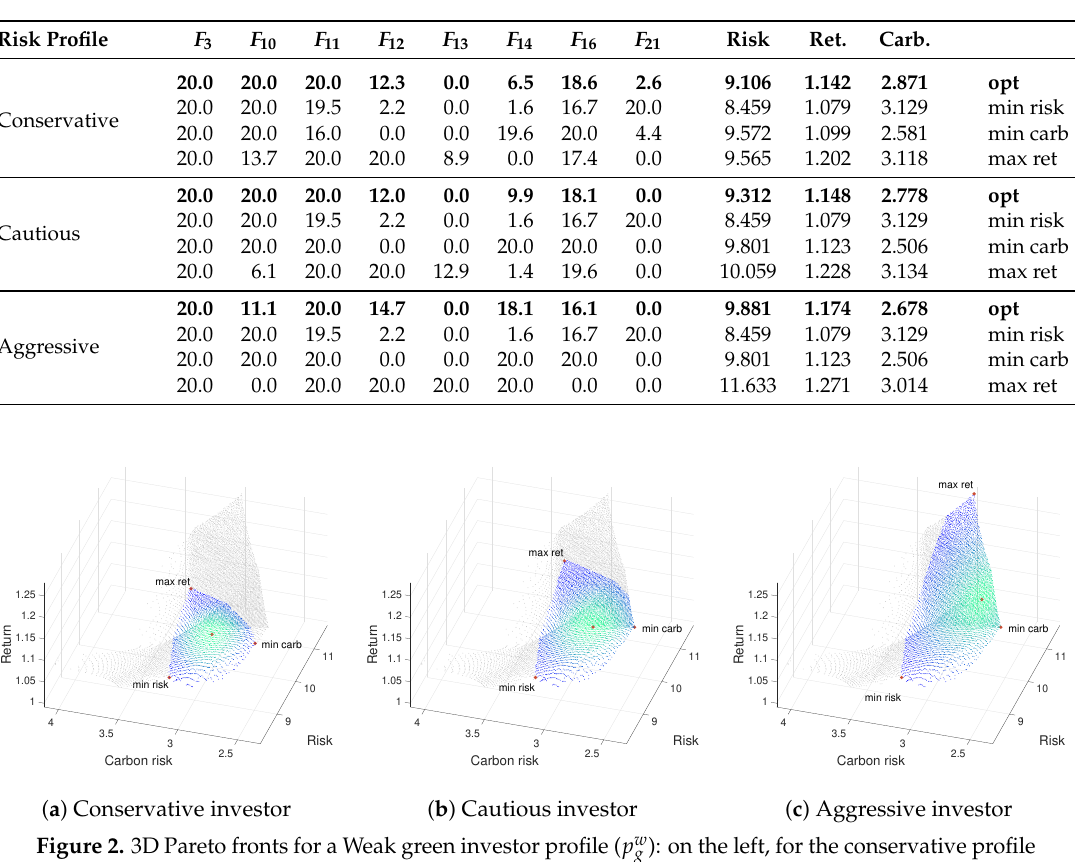
Table 2. Weak green investor portfolio composition and objective value function.